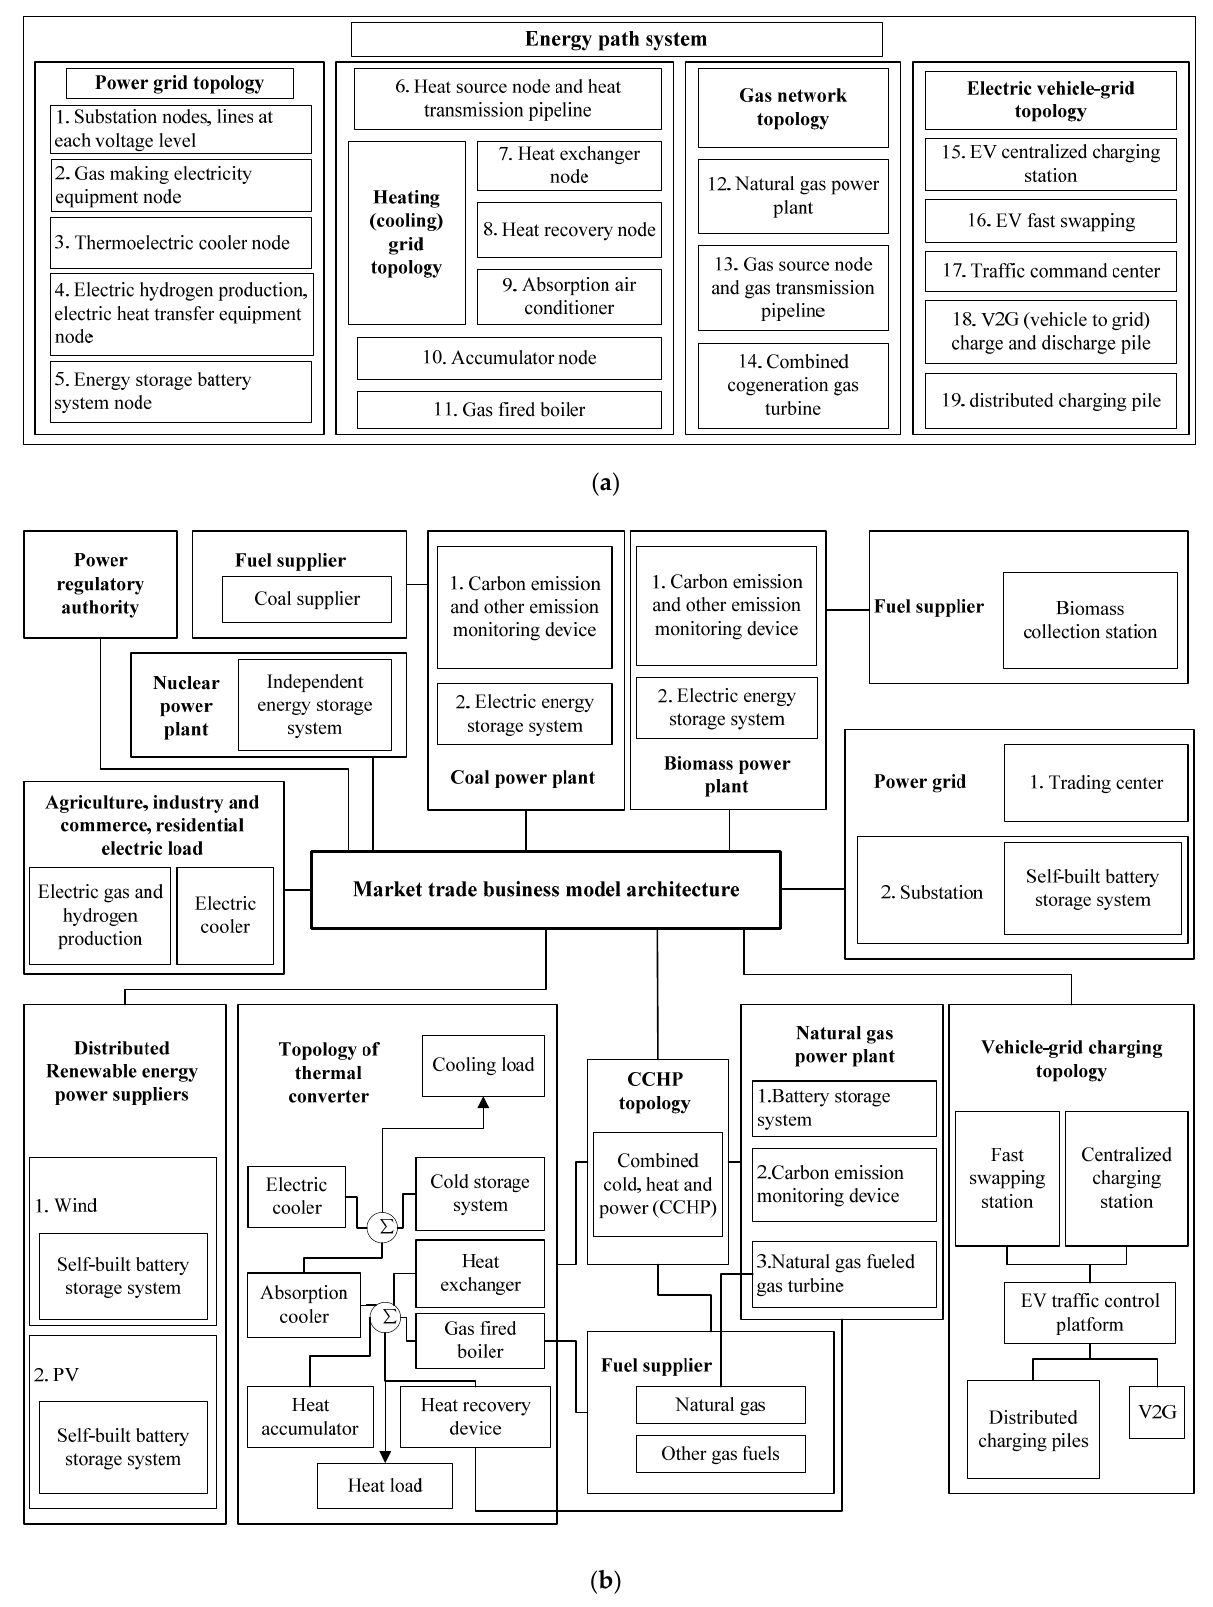
Figure 1. The architecture of a market trade business: ( a ) energy path system; ( b ) market trade business model architecture.